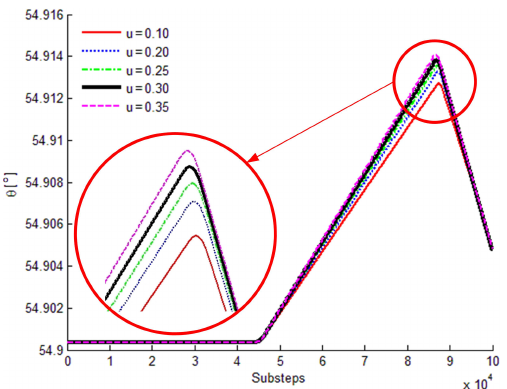
Figure 15. Deflection angle of AB under different friction coeffi-